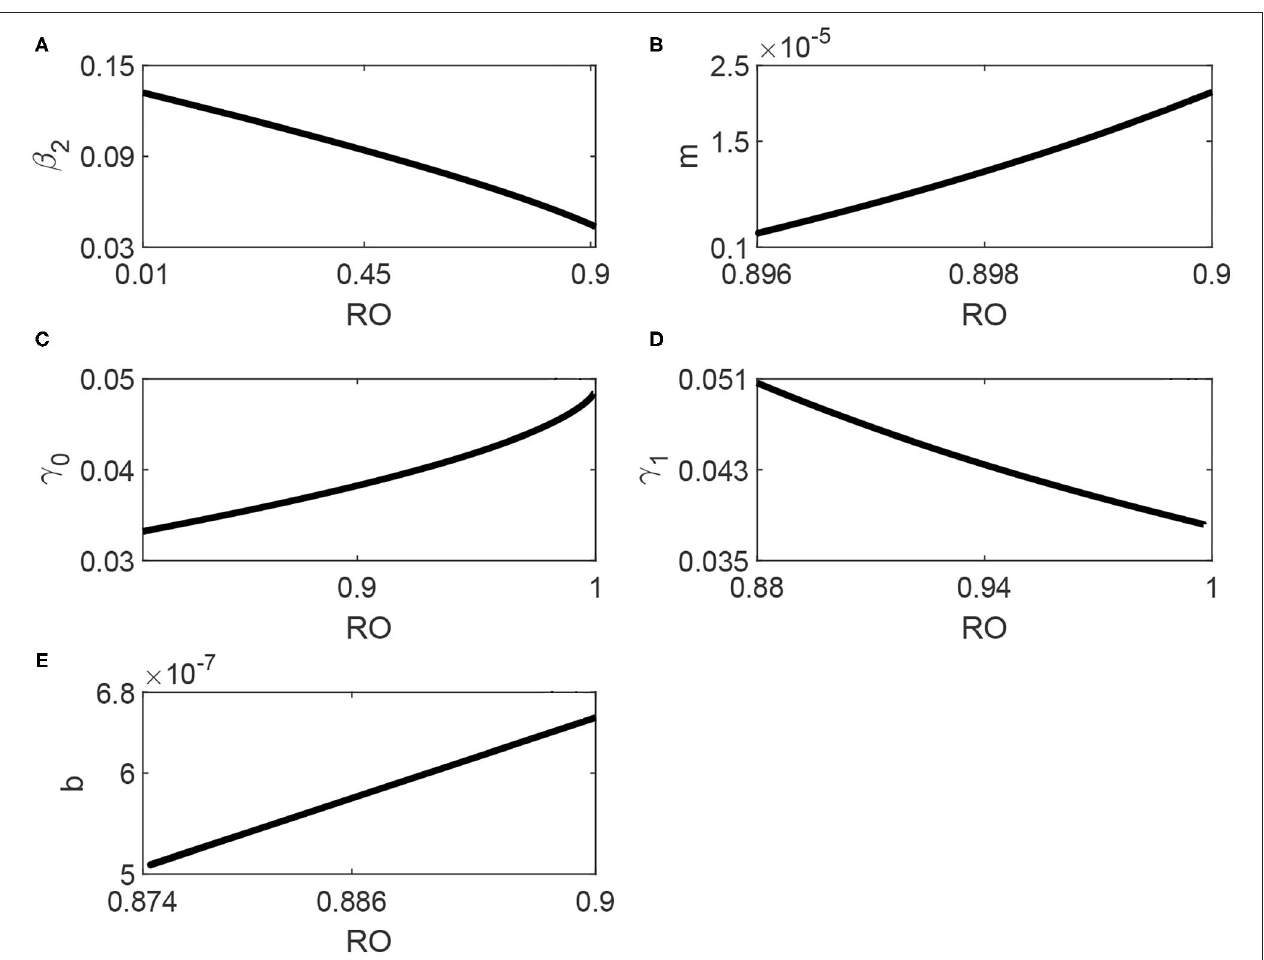
FIGURE 6 | (A–E) Locus of the Hopf point of Figure 3 in terms of the model